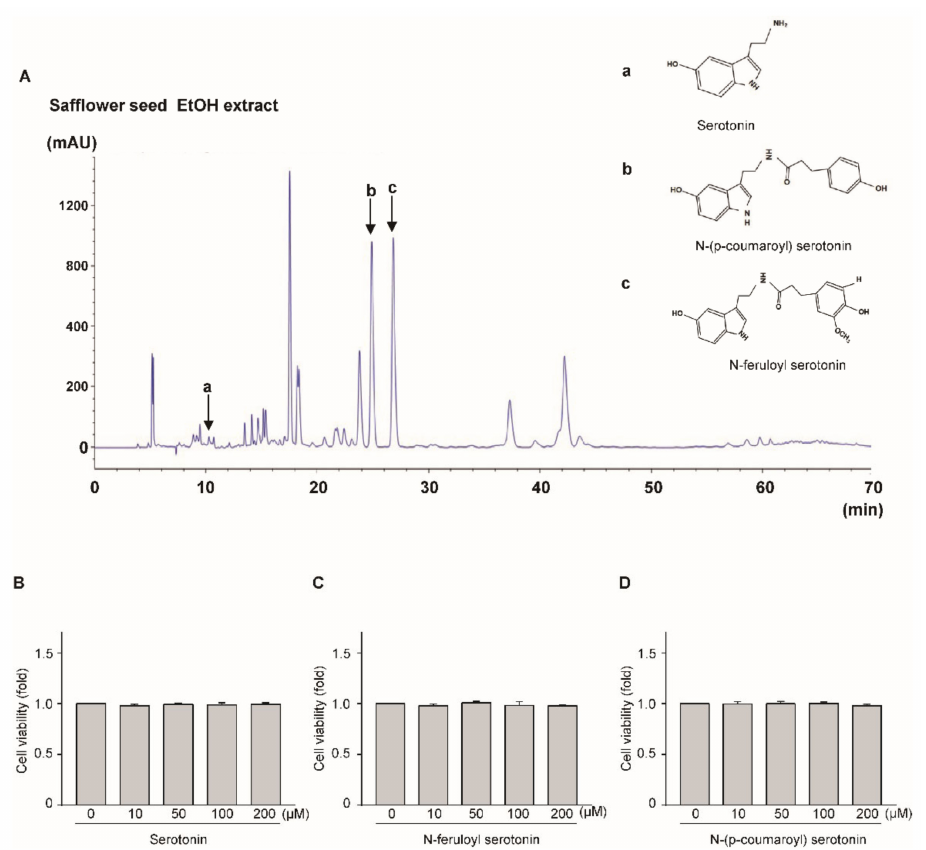
Figure 4. HPLC spectrum of serotonin (a) , N-(p-coumaroyl) serotonin (b) , and N-feruloyl serotonin (c) in safflower seed extract and standard compounds ( A ). Toxicity of serotonin ( B ), N-feruloyl serotonin ( C ) and N-(p-coumaroyl) serotonin ( D ) against chondrocytes. The toxicity of serotonin, N-(p-coumaroyl) serotonin, and N-feruloyl serotonin against chondrocytes was measured at concen- trations of 0, 10, 50, 100, and 200 µ M for 24 h using the LDH